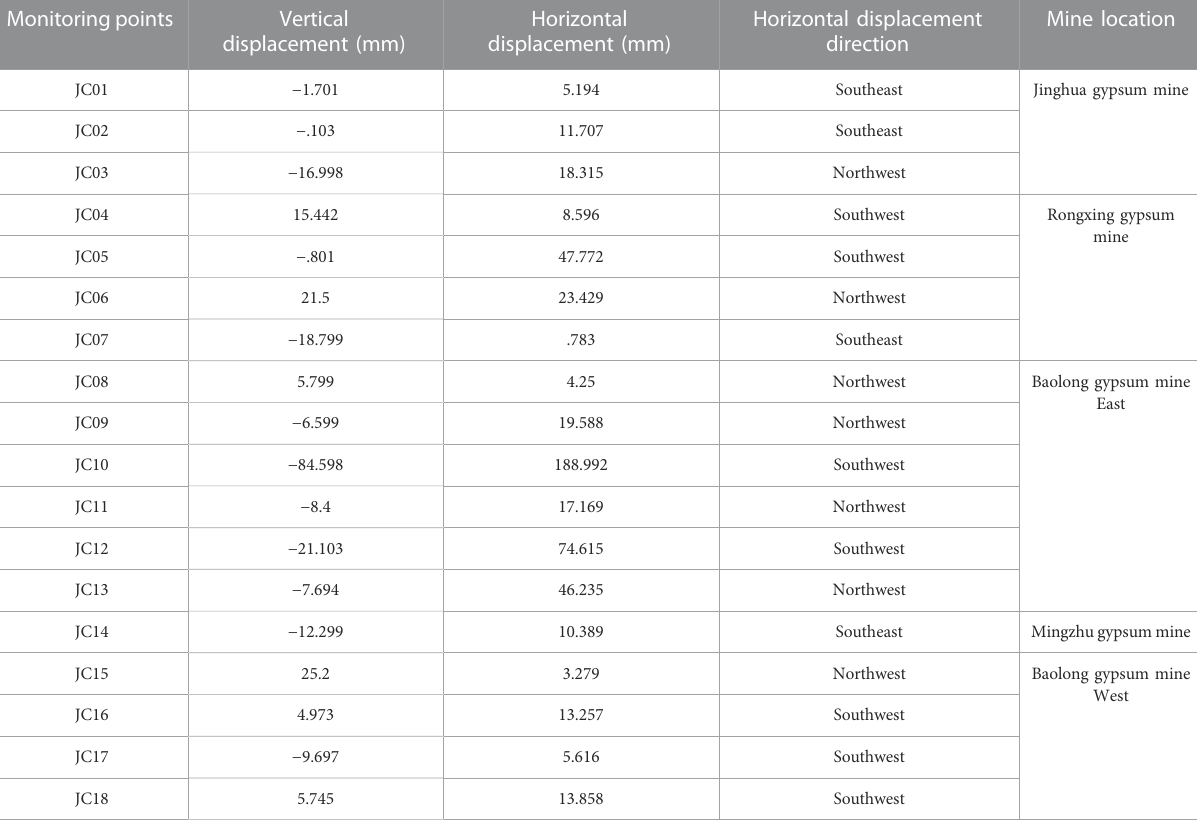
TABLE 6 GNSS surface displacement statistics of the gypsum mining area in the district of Duodao. Monitoring